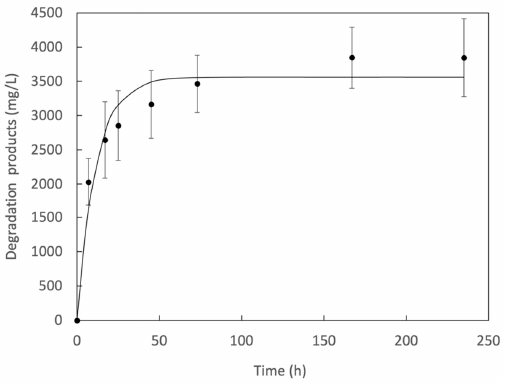
Figure 4. Apparent saturation curve of the PET depolymerization activity of Trx- Is PETase.